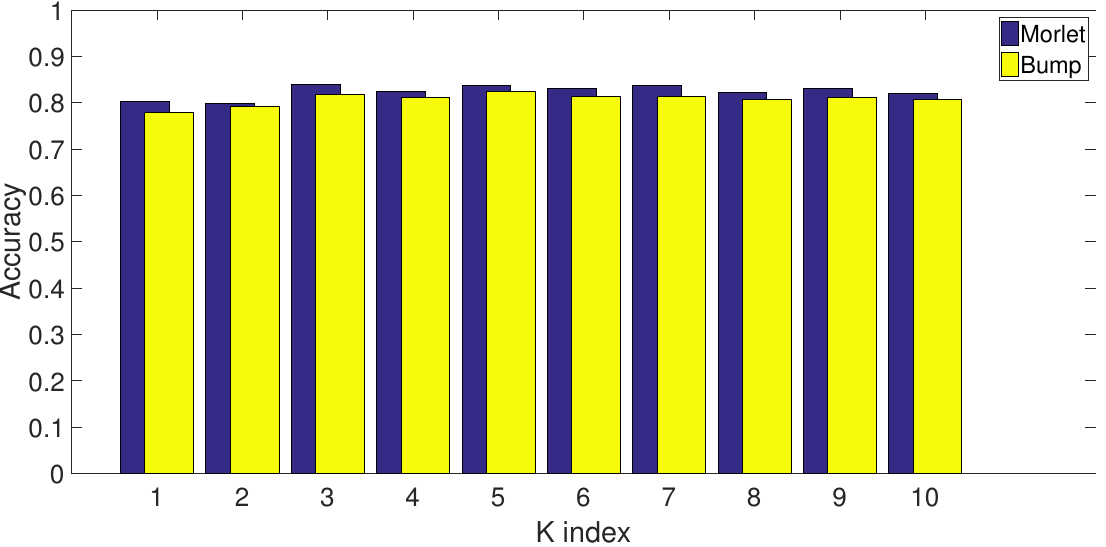
Figure 5. Comparison of the performance accuracy with KNN using Morlet and bump wavelets for different values of K.